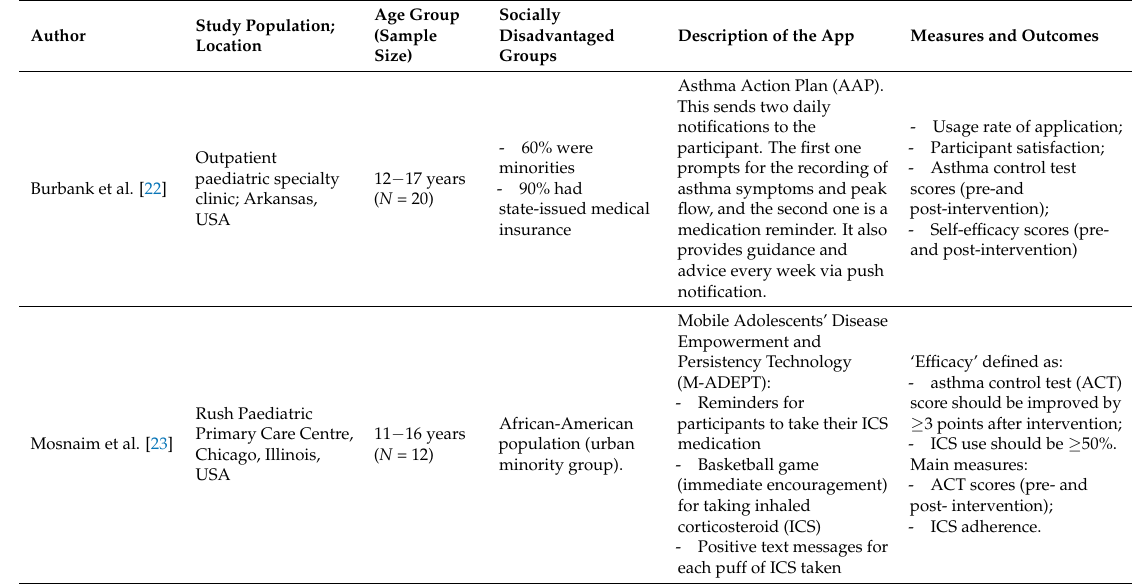
Table 2. Characteristics of the intervention studies.